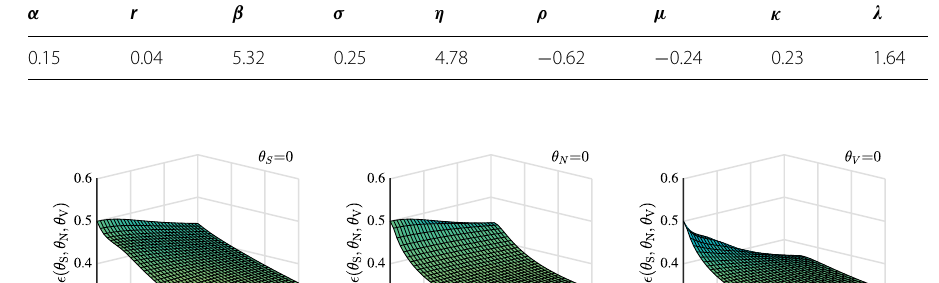
Table 1 Parameter values for our numerical example α r